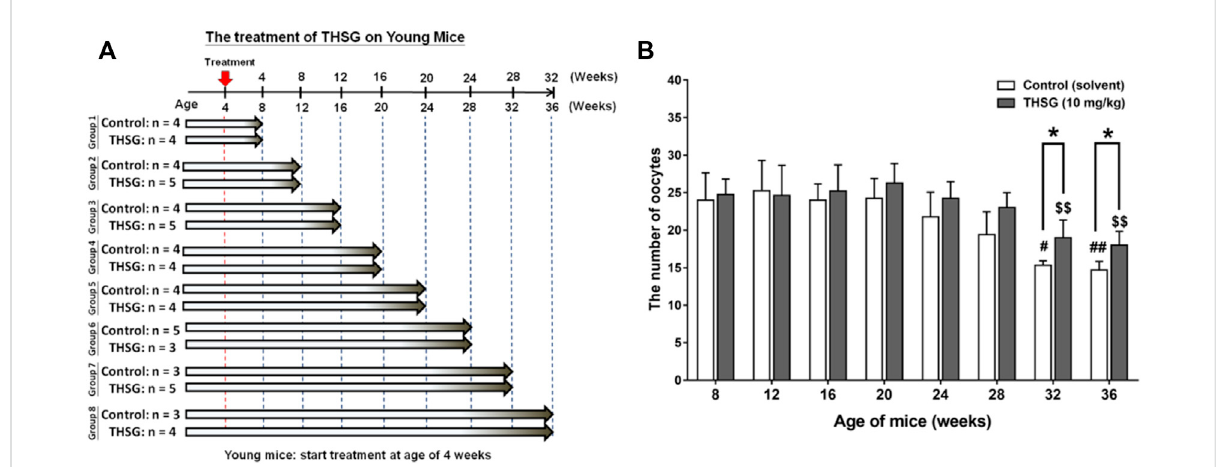
FIGURE 2 THSG treatment enhances oocyte quantity in young mice groups. (A) Female C57BL/6J mice (4 weeks-age) were received 10 mg/kg THSG (in 50%ethanol;experimentgroup)orsolvent(50%ethanol;controlgroup)for32 weeks via gavagefeeding. (B) Oocytesofeachmousewerecollected and counted from oviducts 14 h after hCG administration. Data are expressed as the mean ± SD; * p < 0.05, compared with each age-matched control group; # p < 0.05, ## p < 0.01, compared with the control group of 8-week-old mice; $$ p < 0.01, compared with the THSG-treated group of 8-week-old